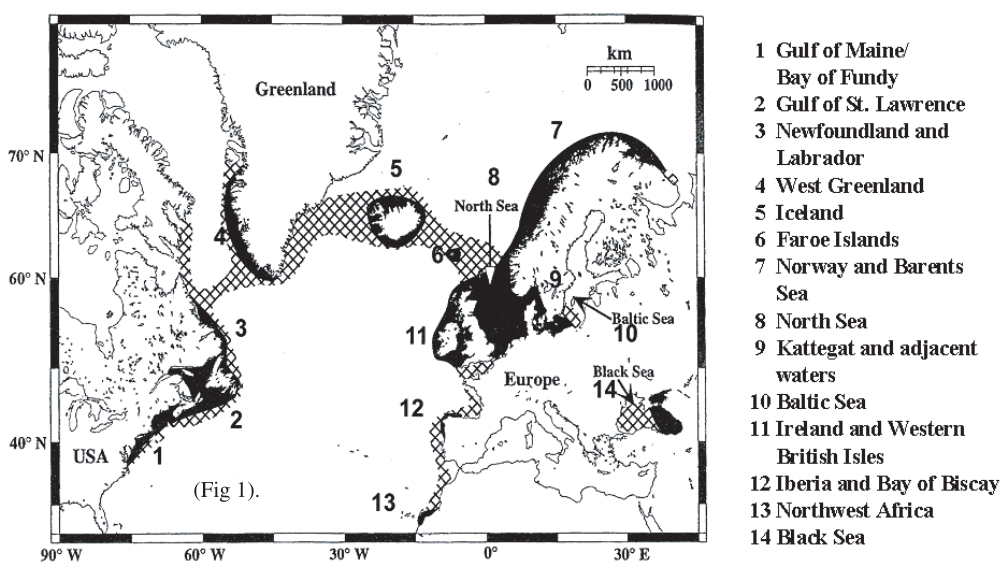
Fig. 1. Map showing the distribution of harbour porpoise populations/sub-populations and possible range in the North Atlantic (After IWC 1996 and Rosel et al. 1999b). Populations and sub-populations and their possible range are indicated by solid black areas, while cross- hatched areas are the possible migration routes across the North